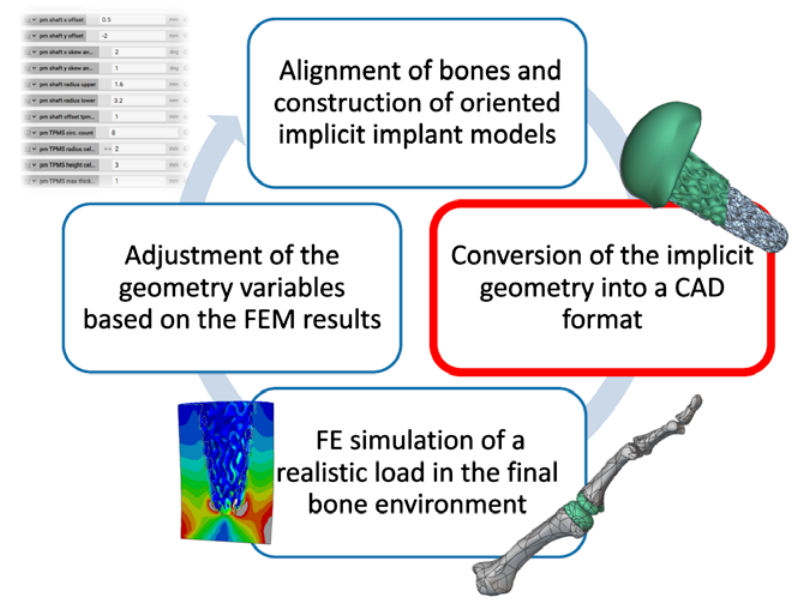
Figure 5. Process for implant design and data processing.